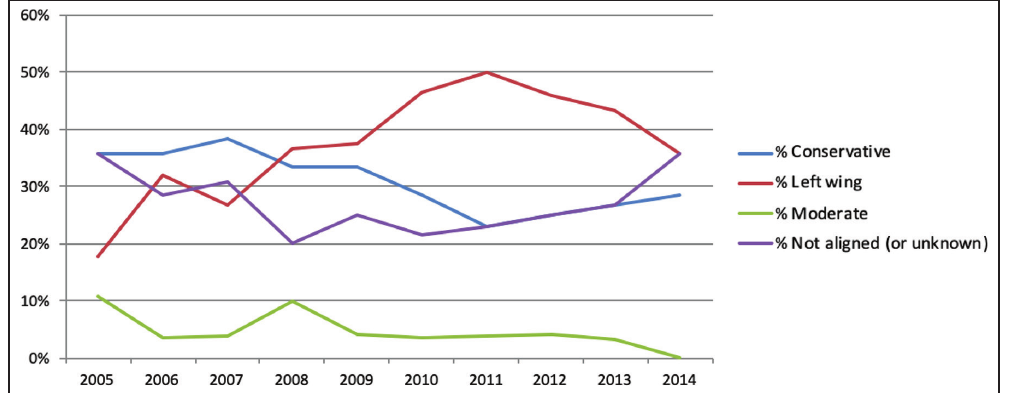
Figure A1 Proportion of magistrates belonging to professional